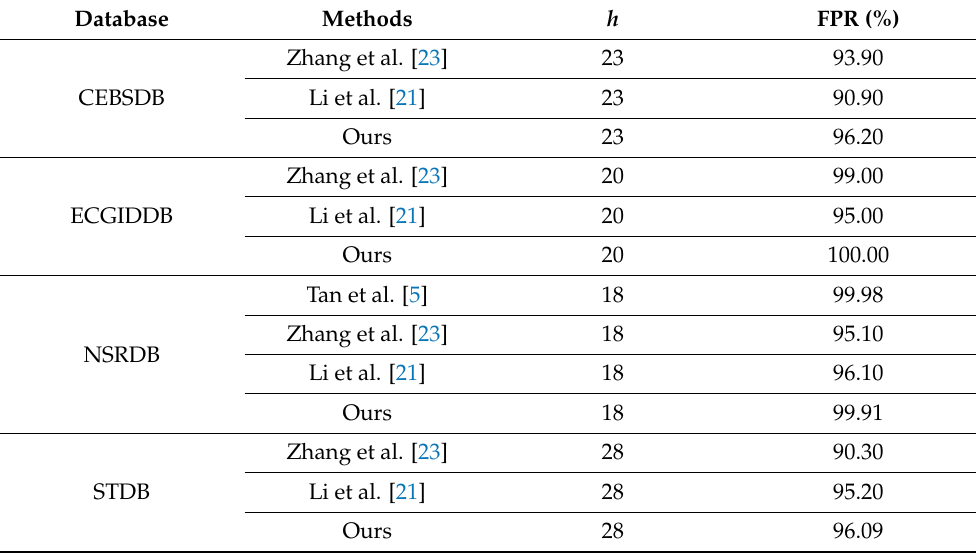
Table 13. Performance comparison of individual verification over short time